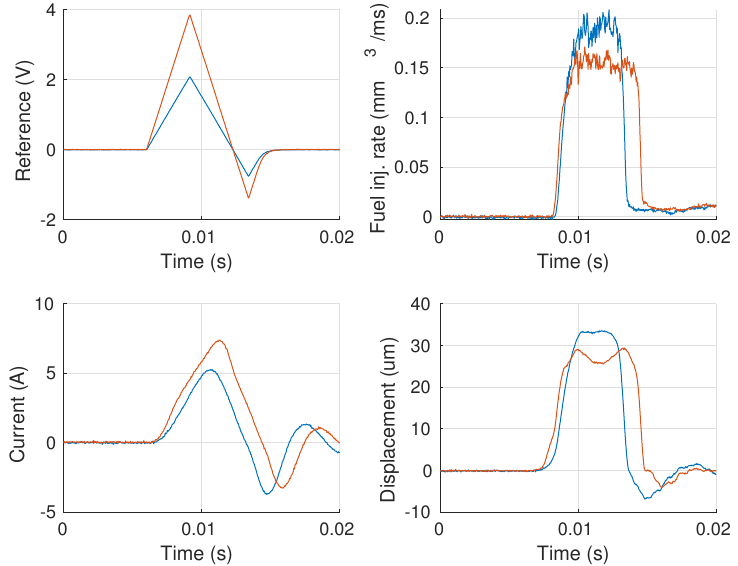
Figure 9. Comparison of measured signals with triangular reference and different amplitudes, with t inj = 5 ms and P inj = 50 MPa.